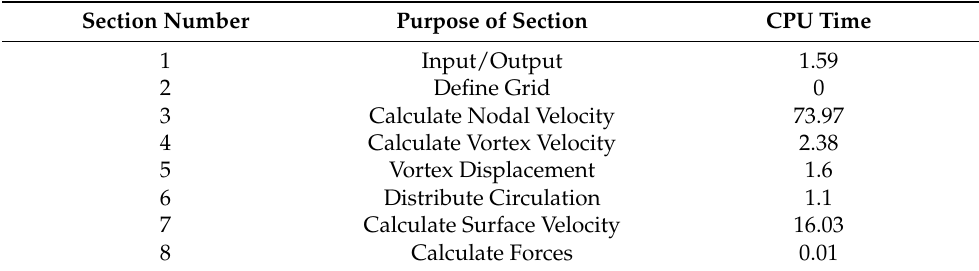
Table 1. The CPU time percentage of the algorithm.